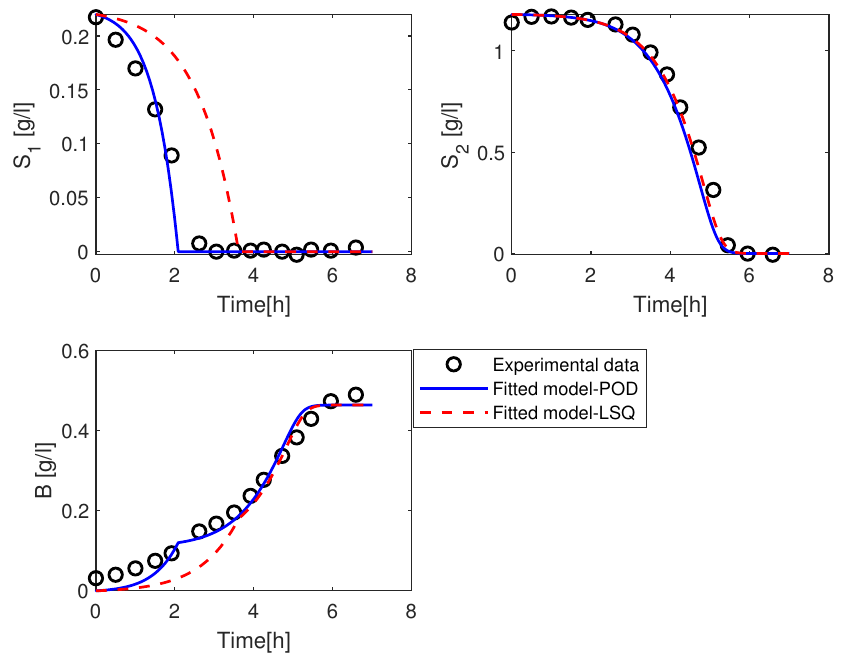
Figure 4. Simulation of the solution of the kinetic model with the parameter value k s 1 using POD method in blue (solid line), LSQ method in red (dashed line), and the experimental data in black (open